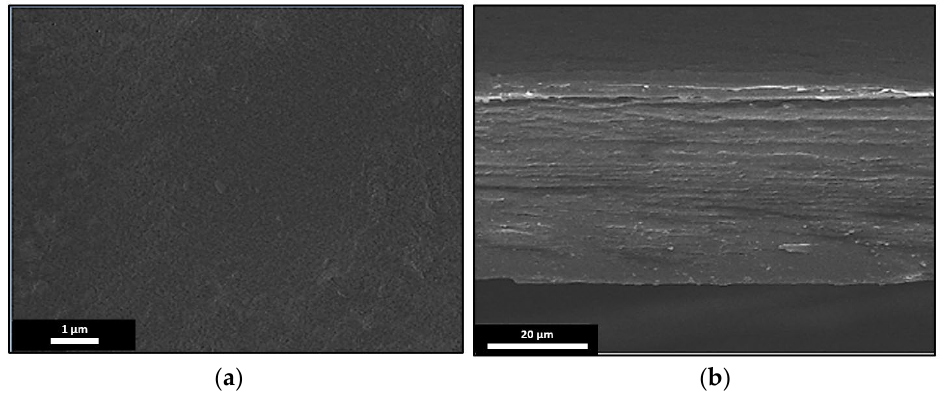
Figure 10. SEM images of ( a ) surface of CTA/AKL/D2EHPA membrane and ( b ) cross-section of CTA/AKL/D2EHPA membrane. Adapted from [91,92].